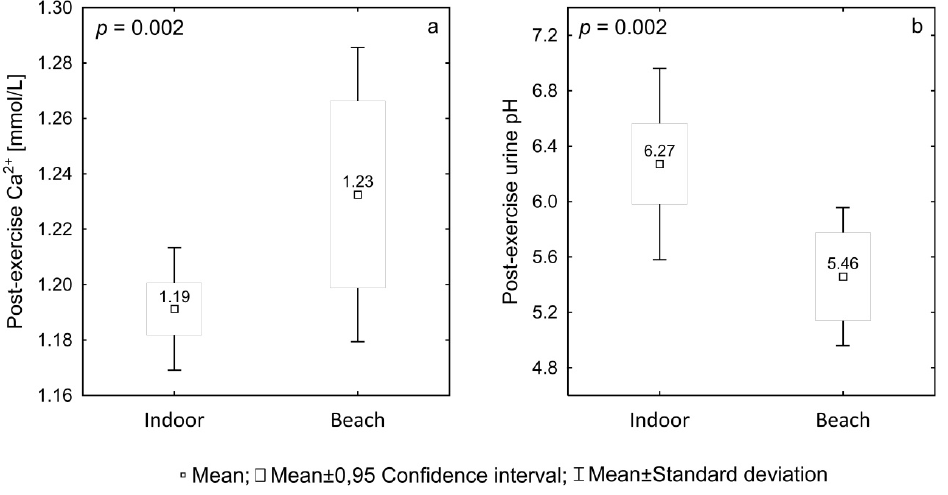
Figure 2. Significant post-exercise differences between simulated matches played indoors and on the + , ( b )—urine beach: ( a )—for Ca 2+ , ( b )—urine pH. beach: ( a )—for Ca 2